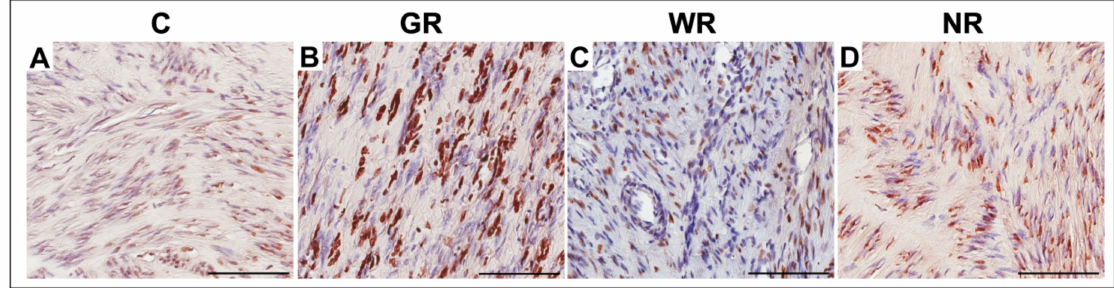
Figure 4. Representative light micrographs of TUNEL-positive myoma cells (brown-stained nuclei) in the control group ( A ), and in the UPA (ulipristal acetate)-treated groups with good ( B ), weak ( C ) and no reaction to treatment ( D ). Scale bar—100 µ m. C—control group, GR—good reaction to treatment, WR—weak reaction to treatment, NR—no reaction to treatment. Table 5. The percentage of terminal deoxynucleotidyl transferase-mediated dUTP nick end-labeling (TUNEL)-positive cells in fibroids in the control group and in the study groups after three months of treatment with ulipristal acetate.